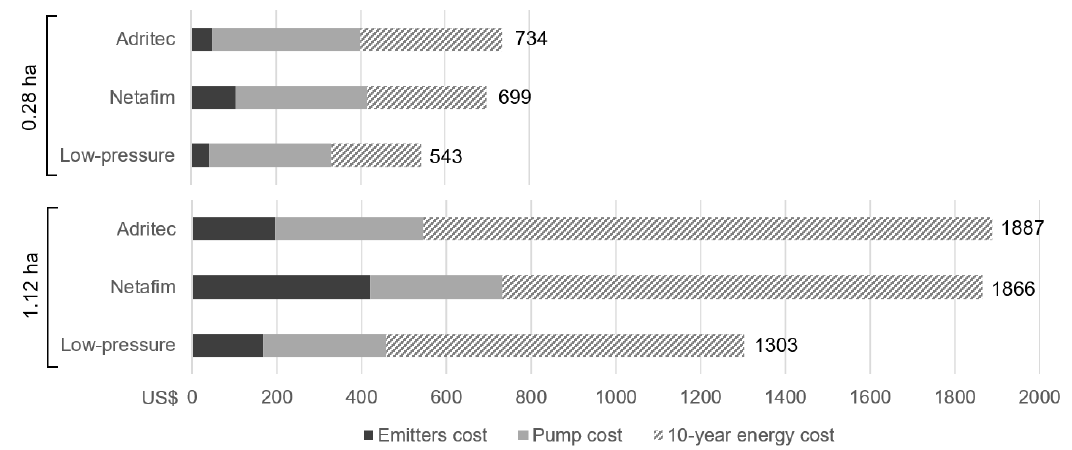
Figure A3. Capital costs for emitters and pumps, and energy costs for a 10-year operational period for the example field (0.28 ha, pomegranate crop, 700 emitters with 8 L / h rated flow rate) and a larger 1.12-ha farm with four plots of that size, irrigated in sequence. Costs in US$ are shown for the three types of emitters, for the pumps required to operate with all emitters above their MCIP and for electricity over a 10-year period.